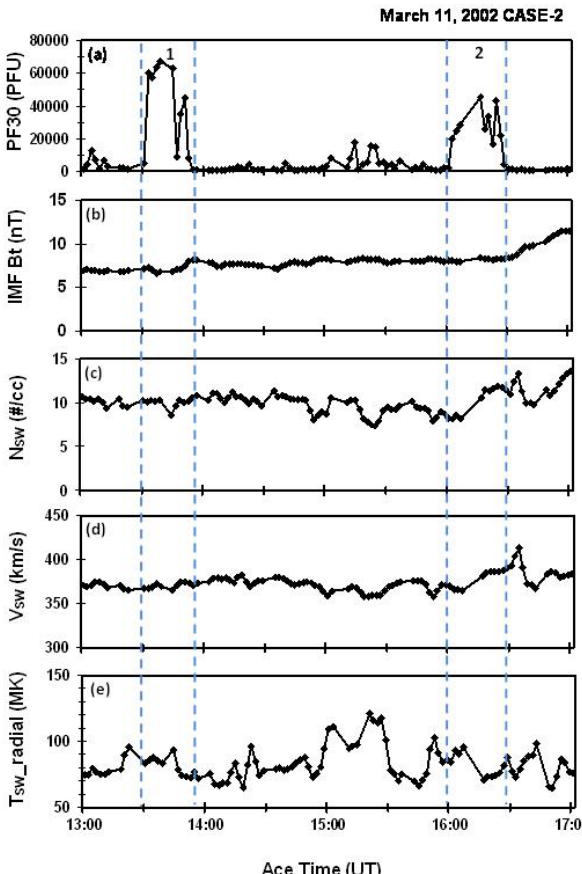
Fig. 13b. ACE solar wind plasma data for Case 2, 11 March 2002. From top to bottom, panels give (a) PF30, (b) IMF strength, (c) den- sity, (d) speed, and (e) proton temperature (radial) versus time. PF30 was added to guide the features in Cluster data. IMF strength Figure 13a was included for easy comparison. Cluster data were shifted to the ACE times concurrently to account for the solar wind convection time from ACE to Cluster. Horizontal axis indicates the time at ACE